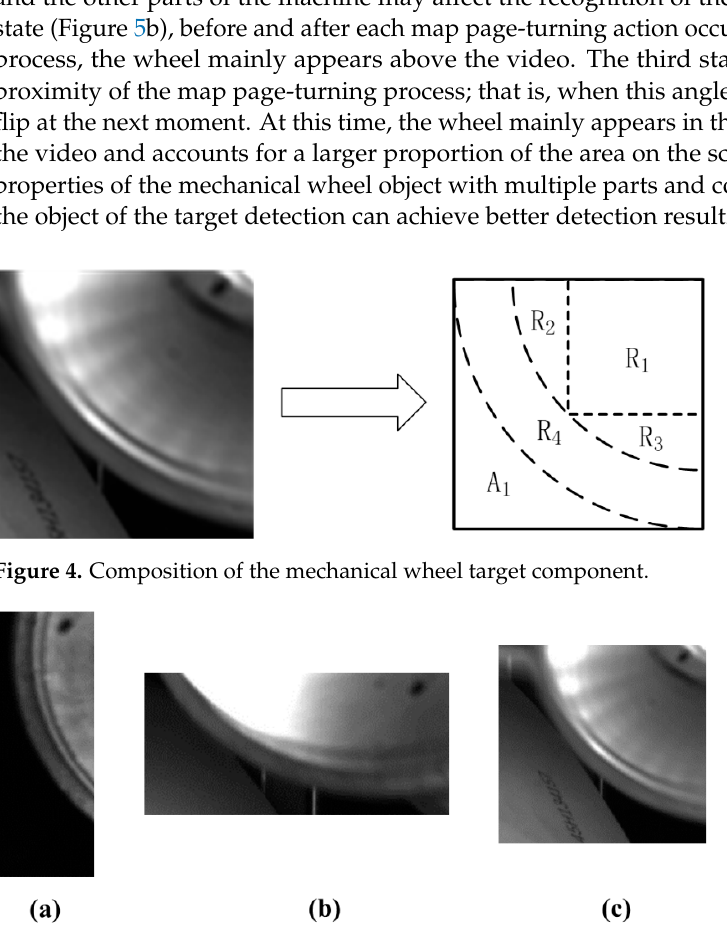
Figure 5. Three states of mechanical wheel targets. ( a ) The first state comprises the mechanical wheel and the other parts of the machine appearing on the video screen at the same time before the equipment starts counting. ( b ) The second state, before and after each map page-turning action occurs during the counting process, the wheel mainly appears above the video. ( c ) The third state is in the proximity of the map page-turning process; that is, when this angle appears, the map will flip at the next moment.